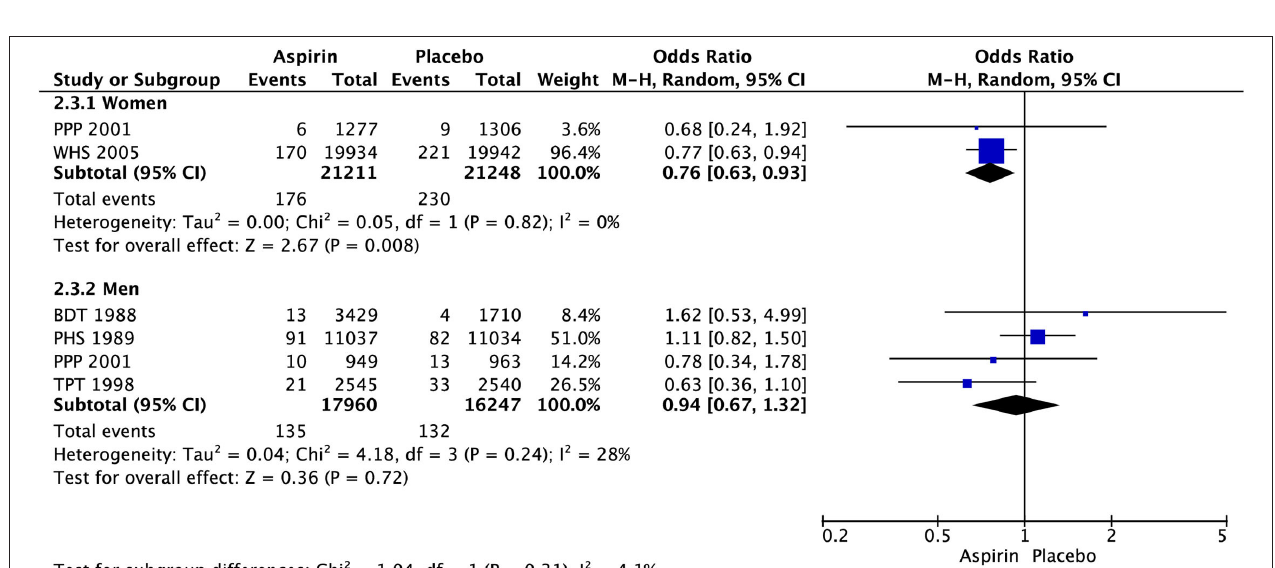
Mortality was not reduced in either women or men taking aspirin ( Table 2 ). 0.003) in 23 006 patients from 4 RCTs ( Figure 9 ), and major